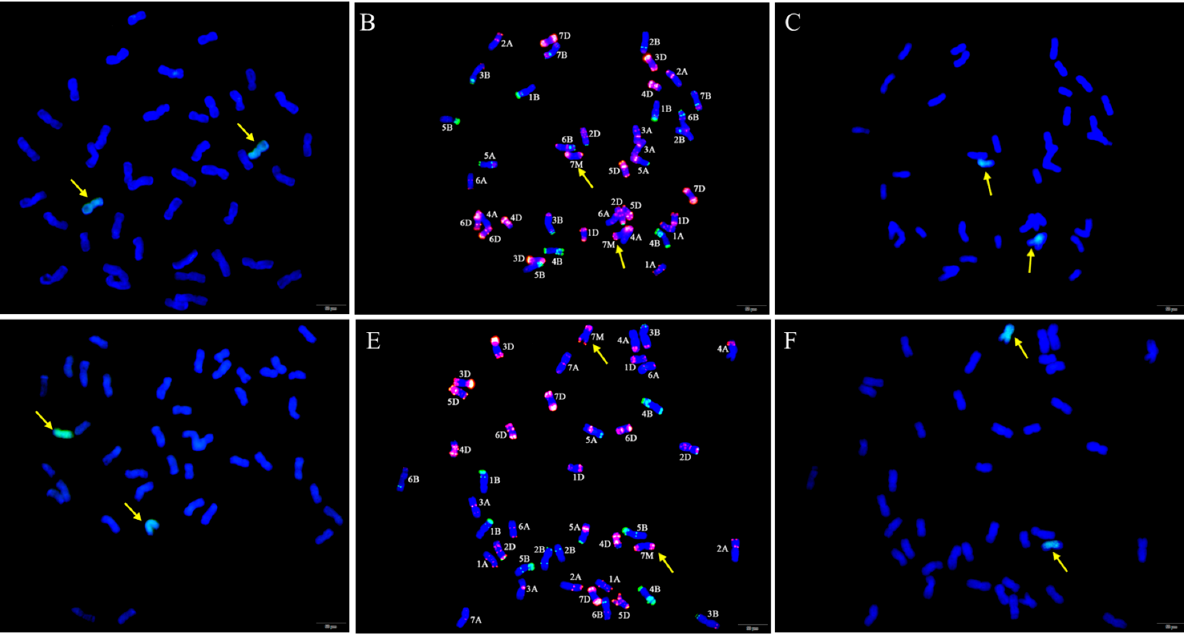
Figure 2. GISH and sequential FISH-GISH analyses of W623 and W637. GISH of a mitotic metaphase cell of W623 ( A ) and W637 ( D ) Ae. geniculata genomic DNA (green) as probe and CS genomic DNA as a blocker. FISH of the mitotic metaphase cells of W623 ( B ) and W637 ( E ) using Oligo-pSc119.2 (green) and Oligo-pTa535 (red) were used as probes. GISH in sequential FISH-GISH of W623 ( C ) and W637 ( F ). The yellow arrows indicate Ae. geniculata chromosomes in W623 and W637.